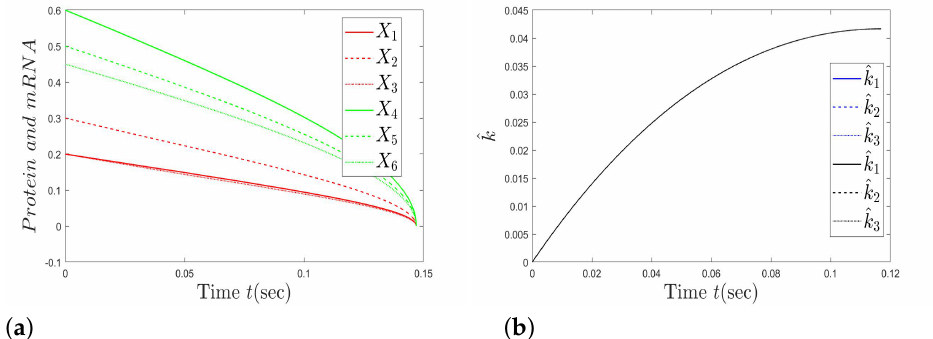
Figure 1. The adaptive design of non-switched SGRNs with time-varying delay, where the con- troller is (6) and the adaptive law is (7). ( a ) Evolution of mRNA X 1 , X 2 , X 3 and protein molecules X X X 5 , 6 , ( b ) evolution of the controller gain of mRNA k 1 , k 2 , k 3 and protein molecules k 4 , k 5 , k 6 4 ,